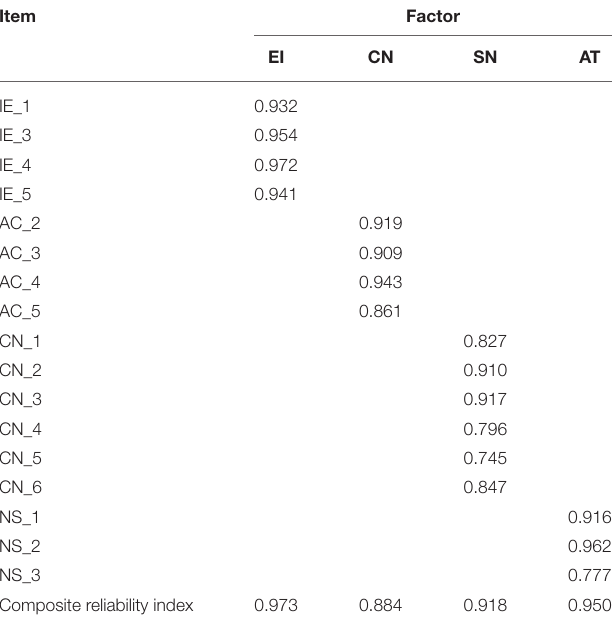
FIGURE 2 | Entrepreneurship intention—measure model. TABLE 5 | Composite reliability